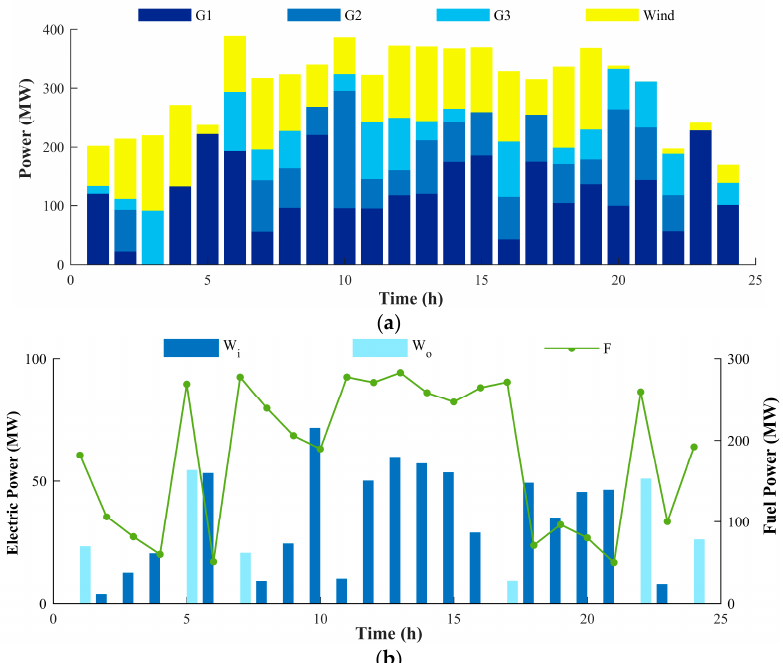
Figure 9. Dispatch result in Case 2. ( a ) Outputs of conventional generators and the wind turbine. ( b ) Input and output of the CCHP plan.